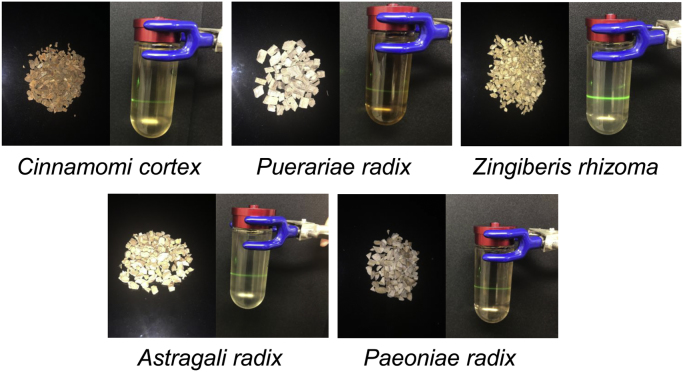
Cut herbal and Tyndall phenomenon in 10 times diluted boiling herbal water extracts, Cinnamomi Cortex (a), Puerariae Radix (b), Zingiberis Rhizoma (c), Astragali Radix (d) and Paeoniae Radix (e).